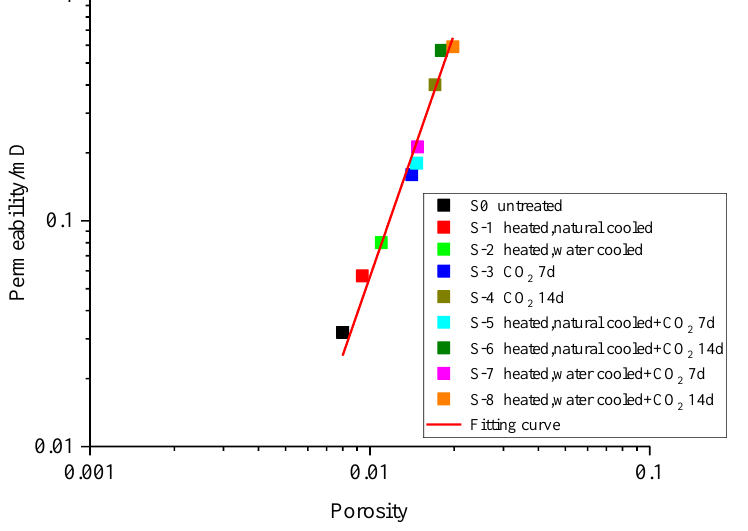
Figure 8. Relationship between permeability and porosity for granite after different types of stimu- lation.